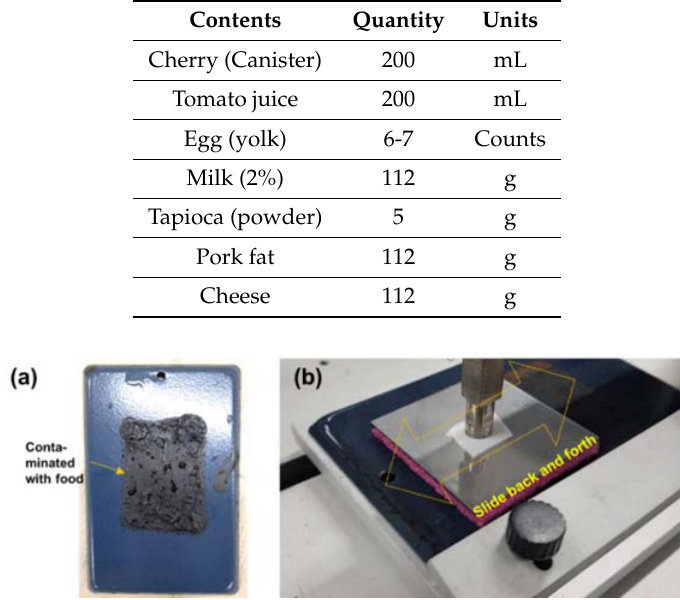
Figure 2. Optical images of ( a ) enamel ‐ coated steel substrate after burnt contamination treatment and ( b ) experimental settings for washability test.